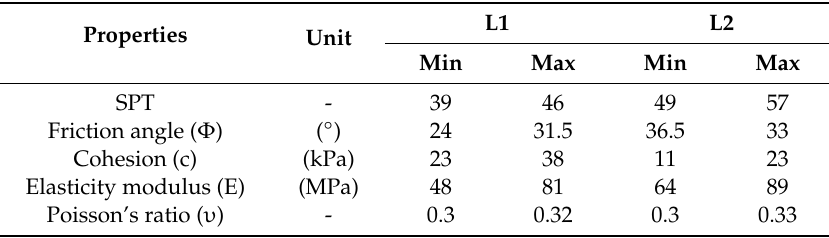
Table 2. Mechanical Properties of soil layers in Part I of